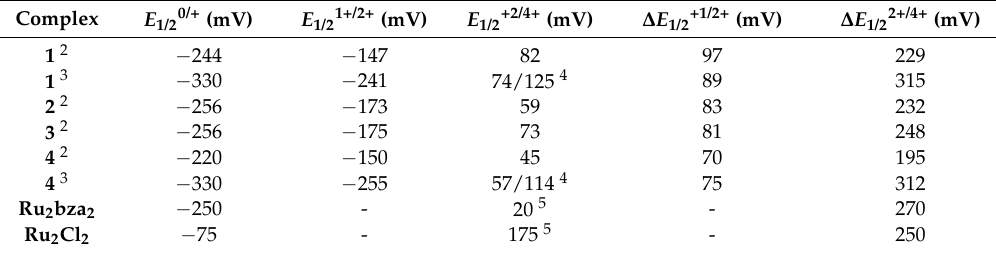
for the +/2+ wave, which phenomenologically corresponds to the 2+/3+ wave of a macrocyclic analog.